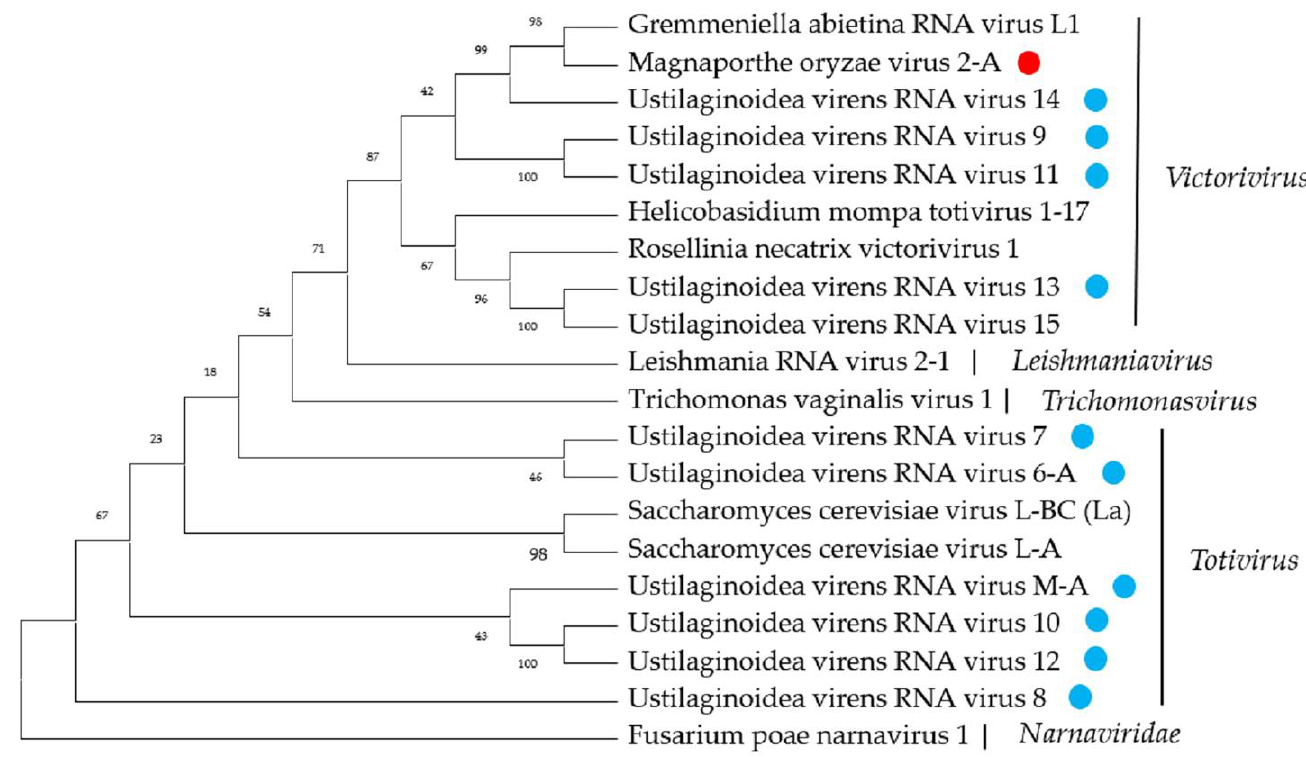
Figure 6. Phylogenetic analysis of viruses in the family Totiviridae . Neighbor-joining-method phylo- genetic tree based on the core RdRP motifs of putative viruses in the family Totiviridae , other related viruses, and representatives of the family. Viruses marked with red color are found in P. oryzae and blue color in U. virens . The viruses without a color annotation are the representatives of the known species of each viral